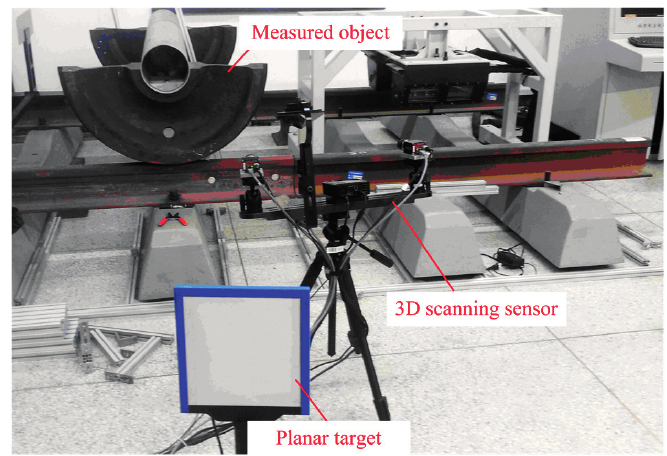
Figure 8. Layout of the physical